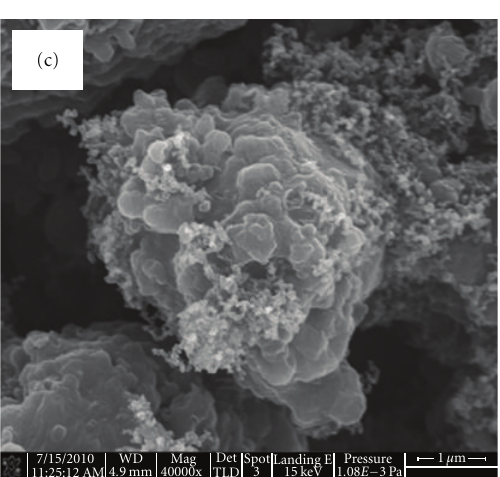
Figure 4: SEM images for (a) Pt, (b) CNTs, and (c) CB coated on MCMB powders. (d) The FE-SEM shows the dispersion of Pt nanoparticles over MCMB surface.